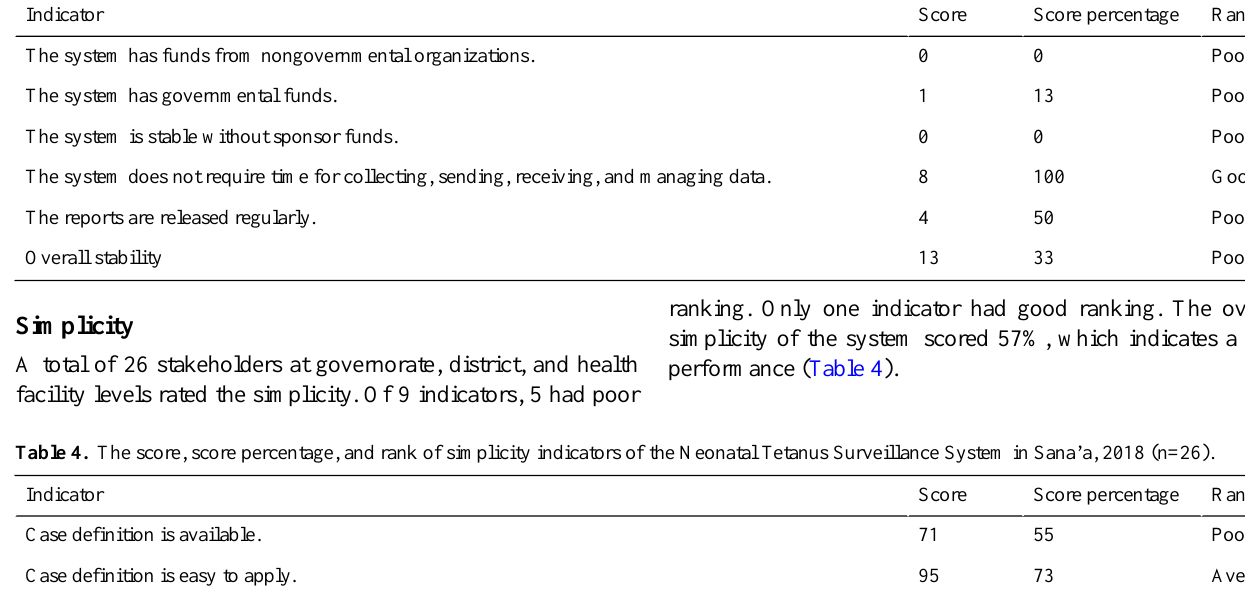
RankScore percentageScoreIndicator